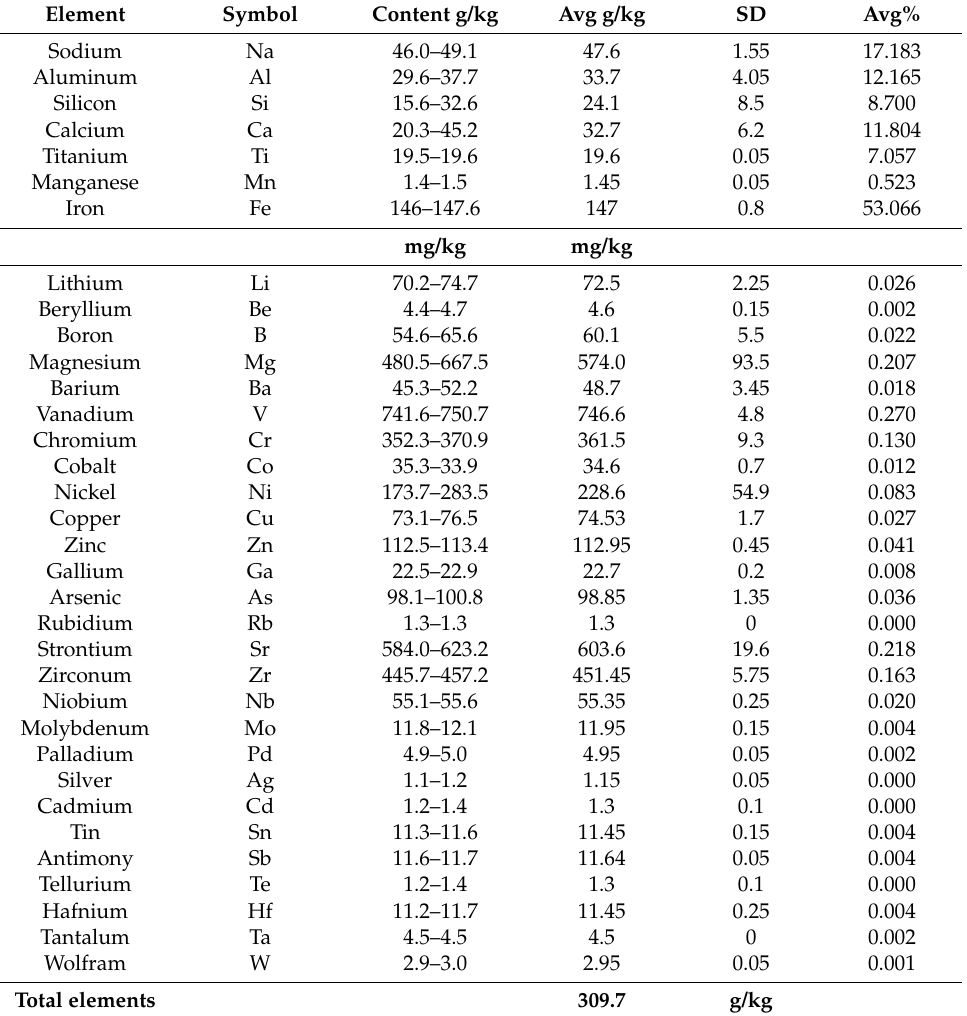
Table 2. Concentration range of the main constituents of red